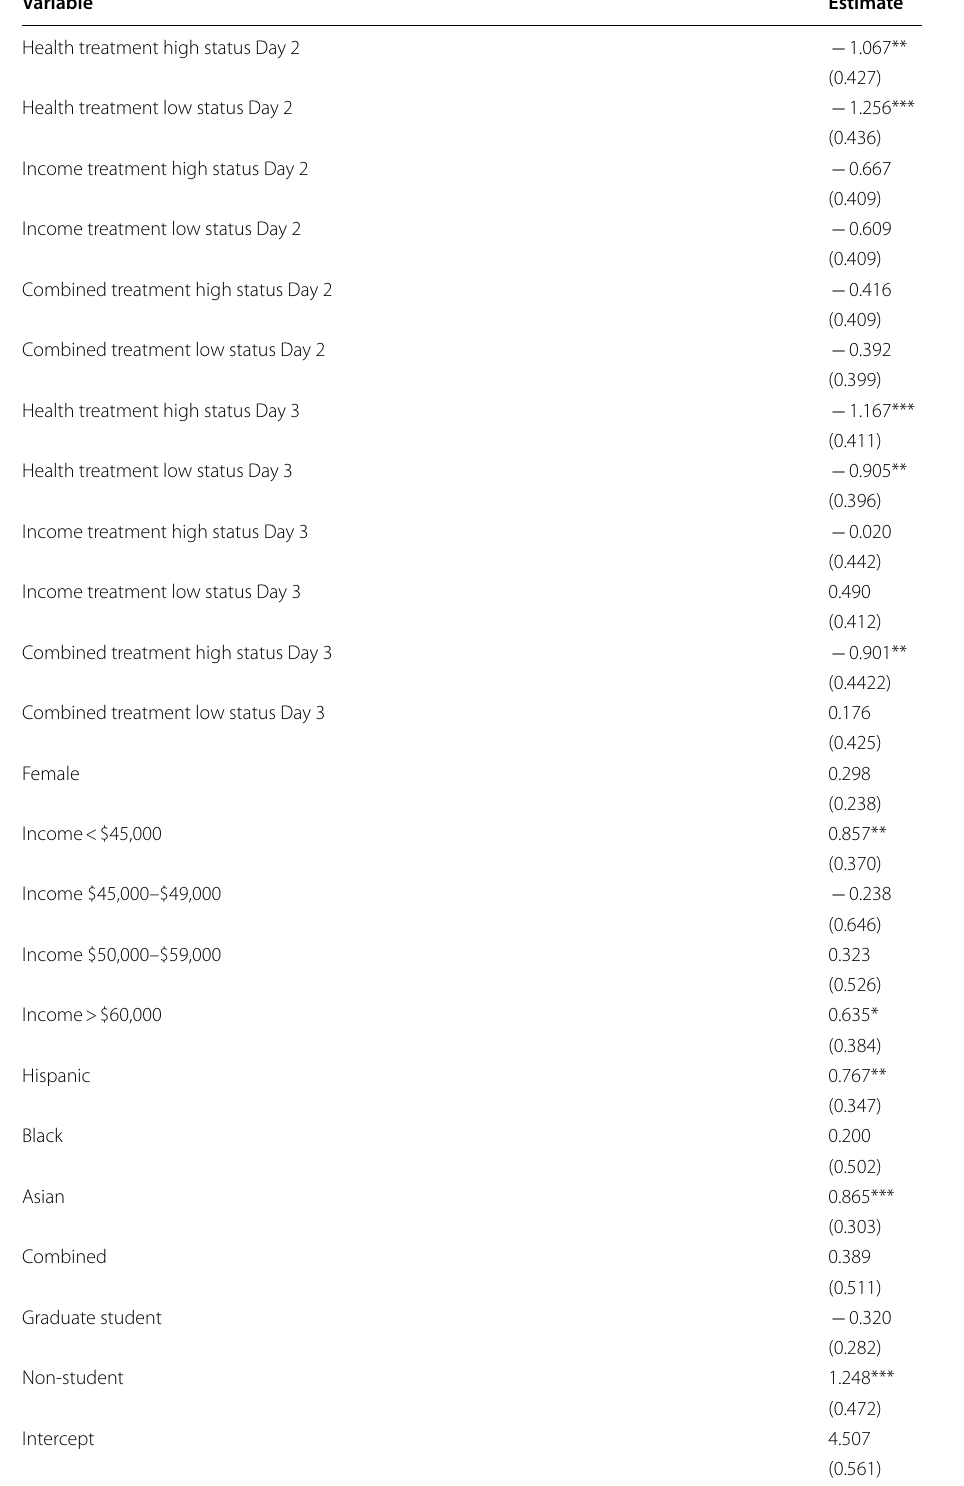
Table 5 Multilevel mixed-effects results for willingness to pay based on treatment, social status, and selected demographic